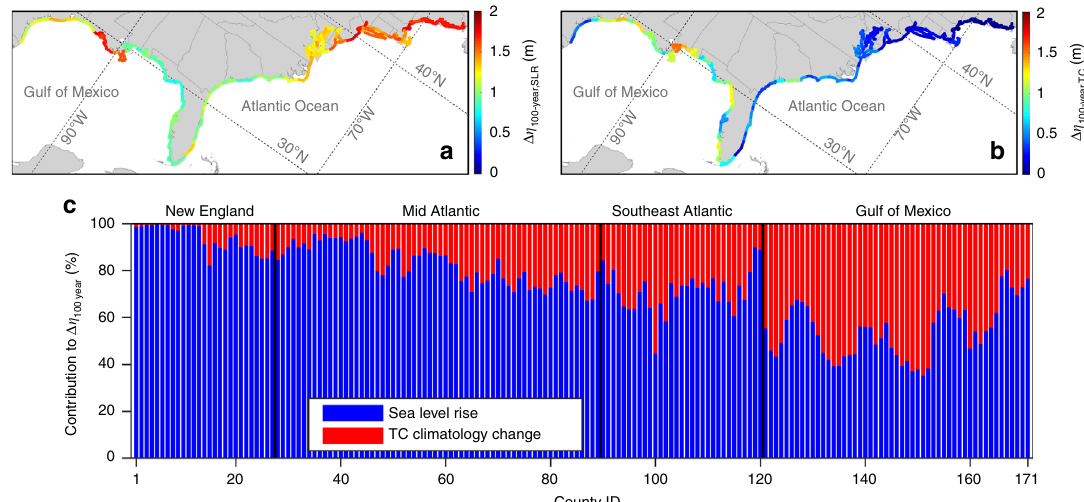
Fig. 4 Projected contributions of SLR and TC climatology change to changes in the 100-year fl ood level. a Changes in η 100 year for the future period of 2070 – 2095 due to SLR ( Δ η 100 year, SLR ). b Changes in η 100 year for the future period of 2070 – 2095 due to TC climatology change ( Δ η 100 year, TC ). c Relative contributions of SLR and TC climatology change to the projected changes in η 100 year . Source data are provided as a Source data fi